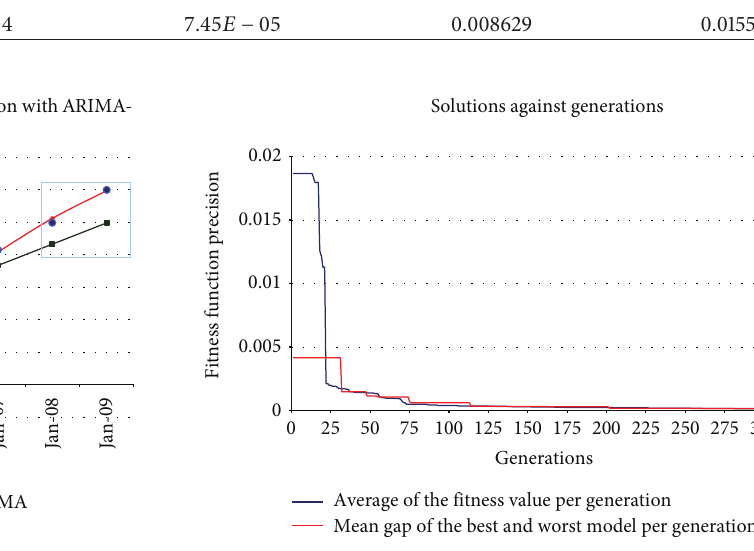
Figure 34: Comparison of the forecasting performances of modified-hGP with ARIMA model (forecast window—2 years ahead) for the number of OECD 3G mobile subscribers.